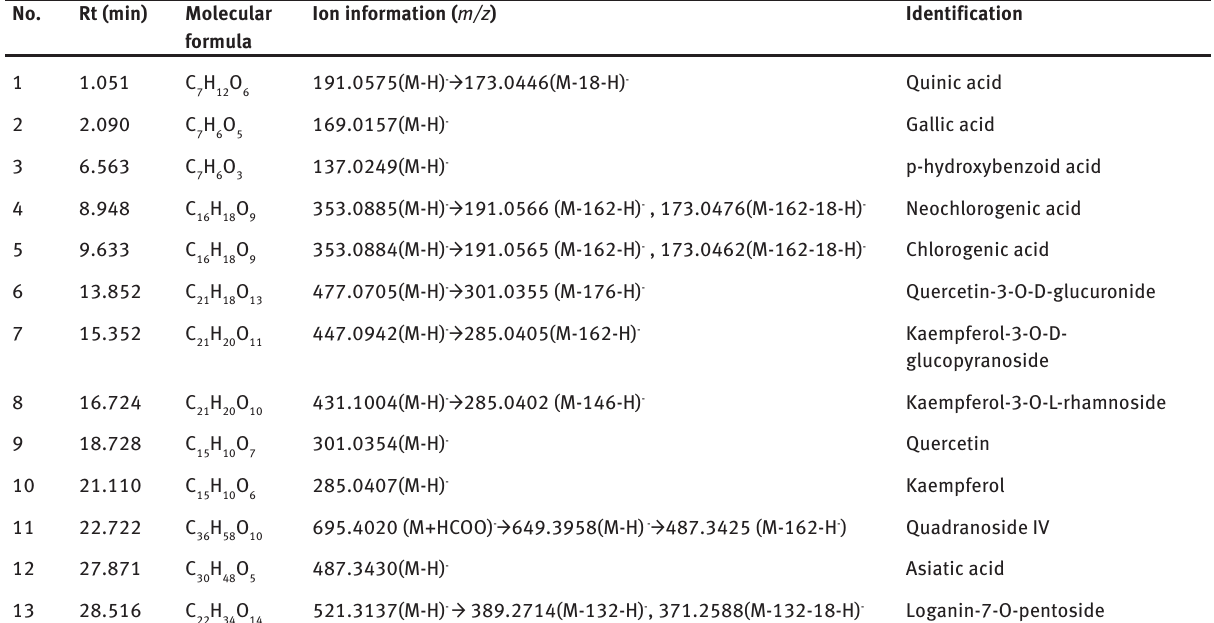
Table 1: LC-MS/MS data for the compounds of CP absorbed into blood. No. Rt (min) Molecular Ion information ( m/z formula